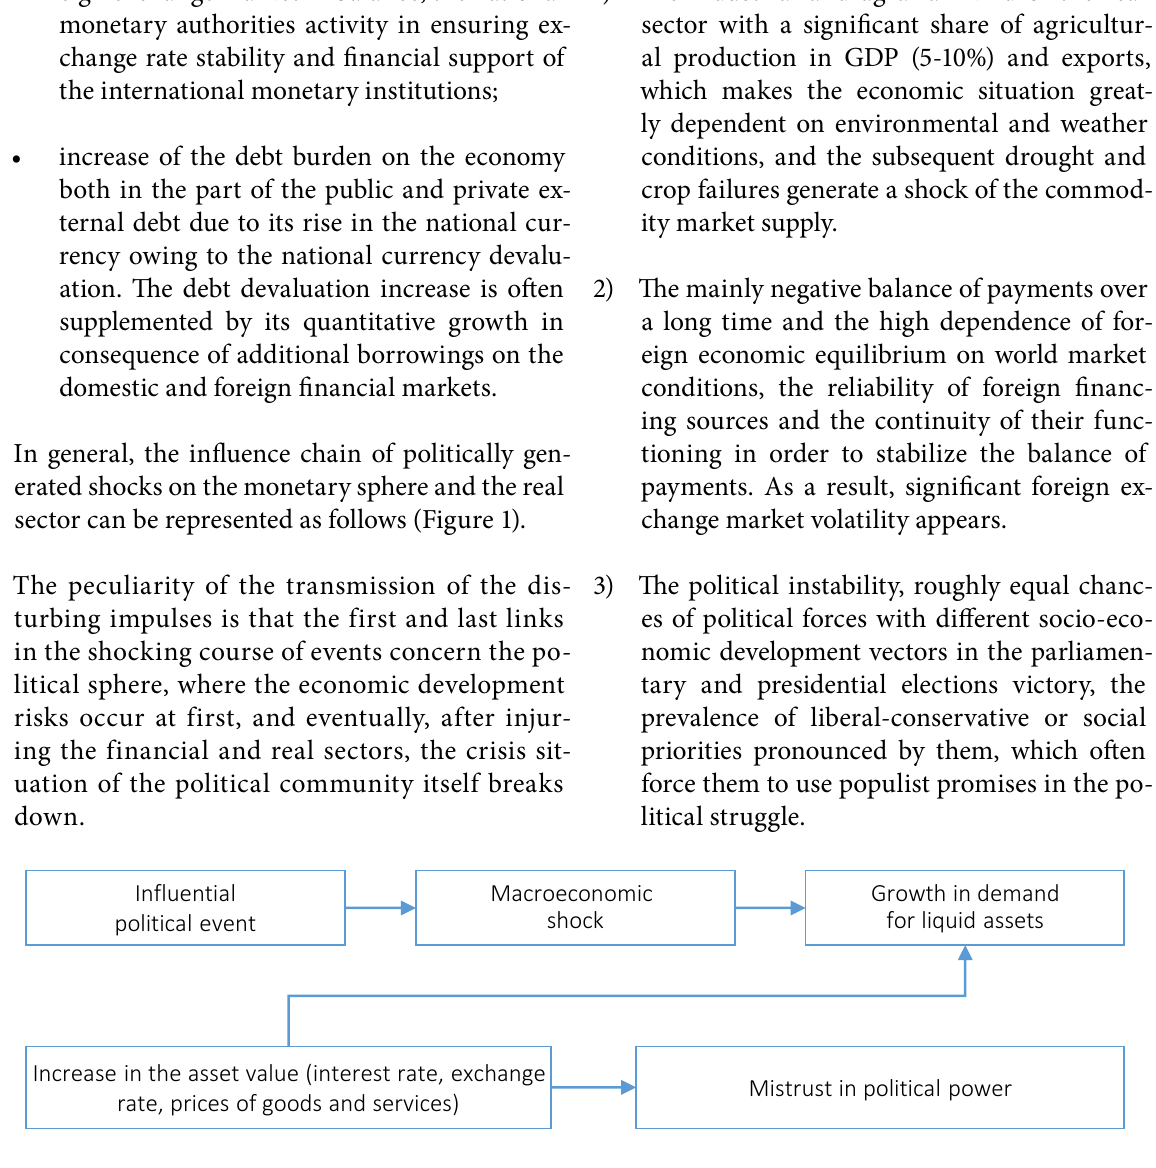
Increase in the asset value (interest rate, exchange Mistrust in political rate, prices of goods and services) Figure 1. Transmission mechanism links of the politically generated shocks affecting the economy